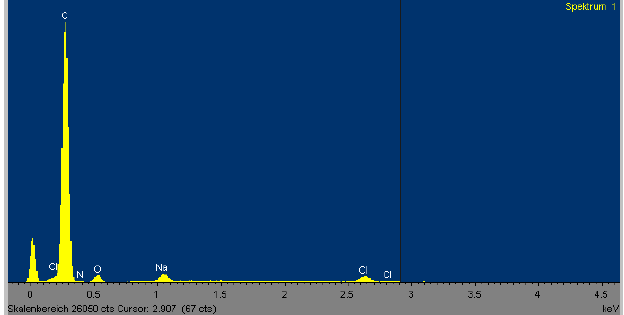
Figure 7. Energy dispersive X-ray microanalysis (EDX) spectrum of an exemplary dish from the negative control group showing no presence of calcium or phosphorus. The high carbon peak is due to the carbon sputtering as demanded for proper EDX scanning.